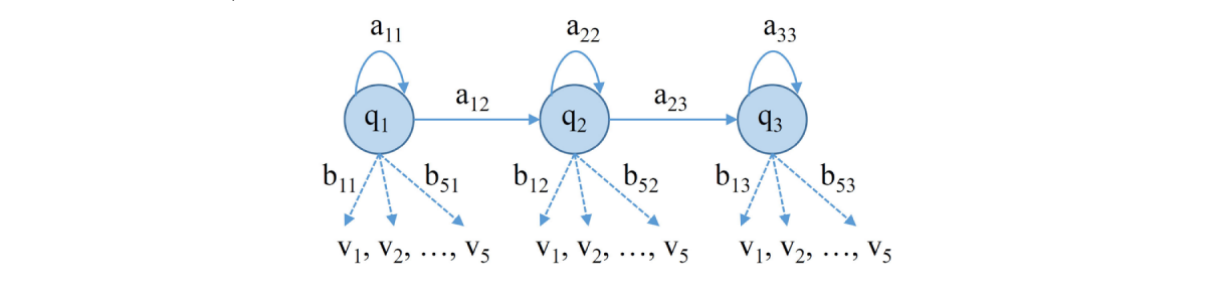
Figure 5. Hidden Markov model with three states (q1 to q3) and five observation symbols (v1 to v5). The relationship among states is described by transition matrix A=[aij]3x3, and between states and discreet symbols by observation matrix B=[bij]3x5. It is assumed the system evolves through certain states whose relationship is to be